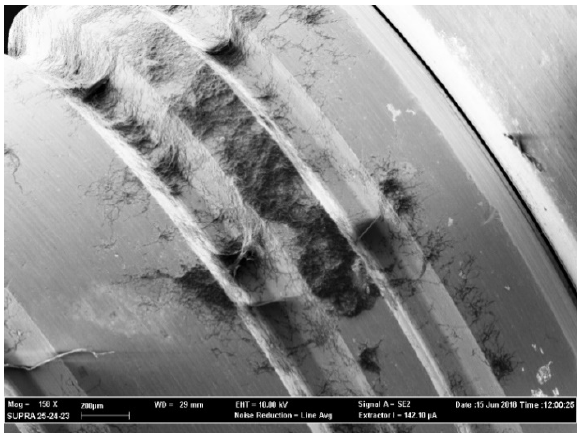
Figure 3. Chlorhexidine (CHX) treatment on a machined implant. Magnification 158×.